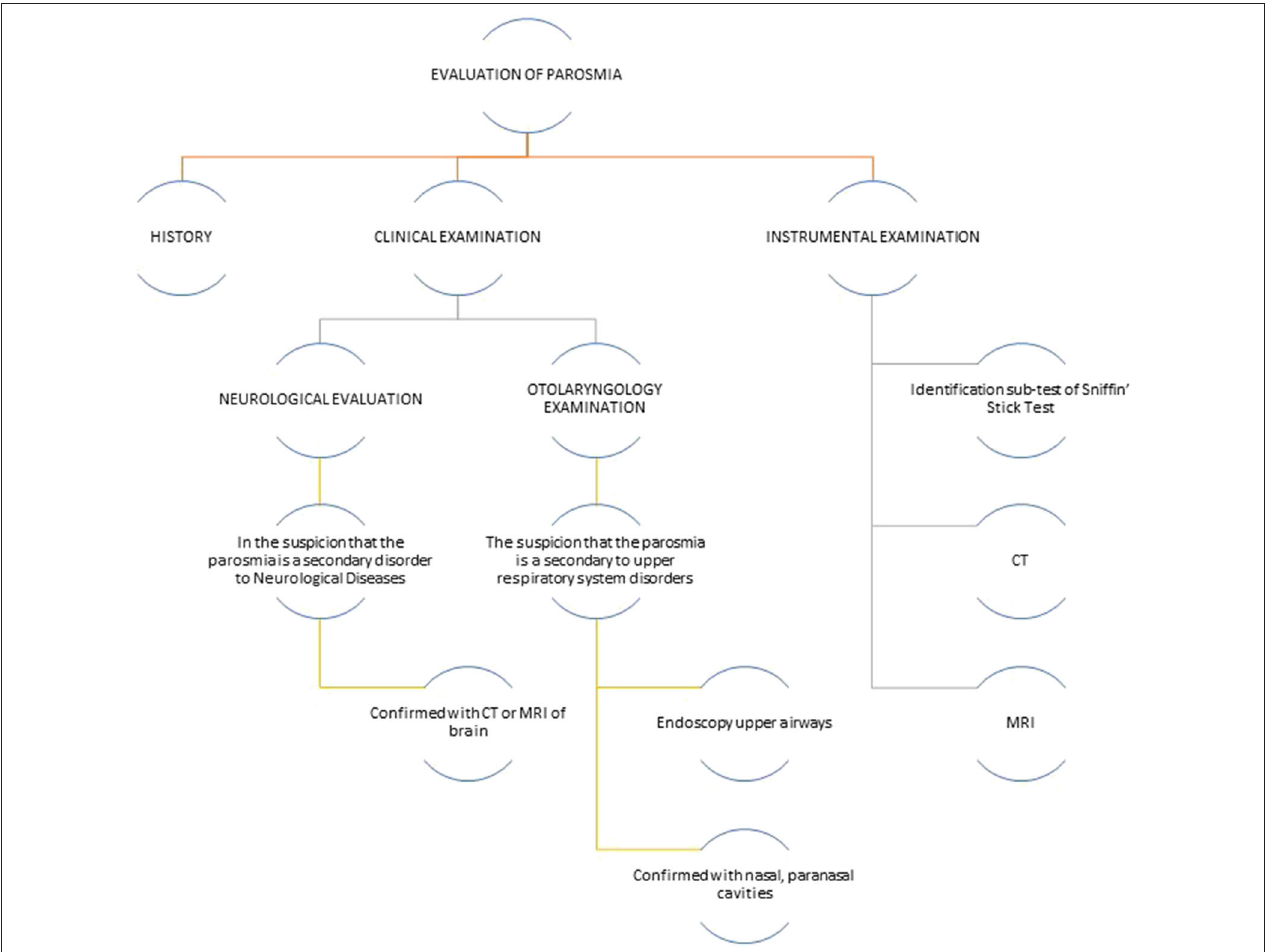
FIGURE 2 | Flowchart of olfactory disorders assessment. CT, computed tomography; MRI, magnetic resonance